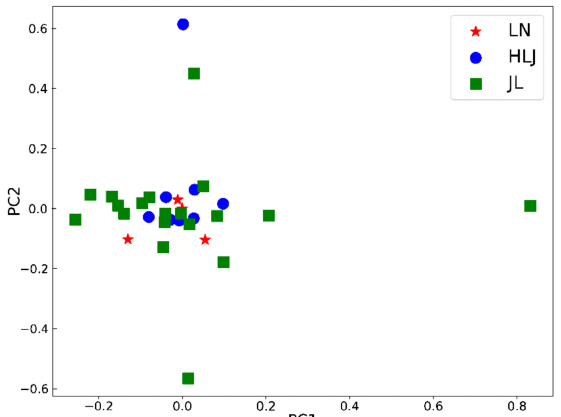
Figure 2. PCA results of ginseng from three geographical origins.